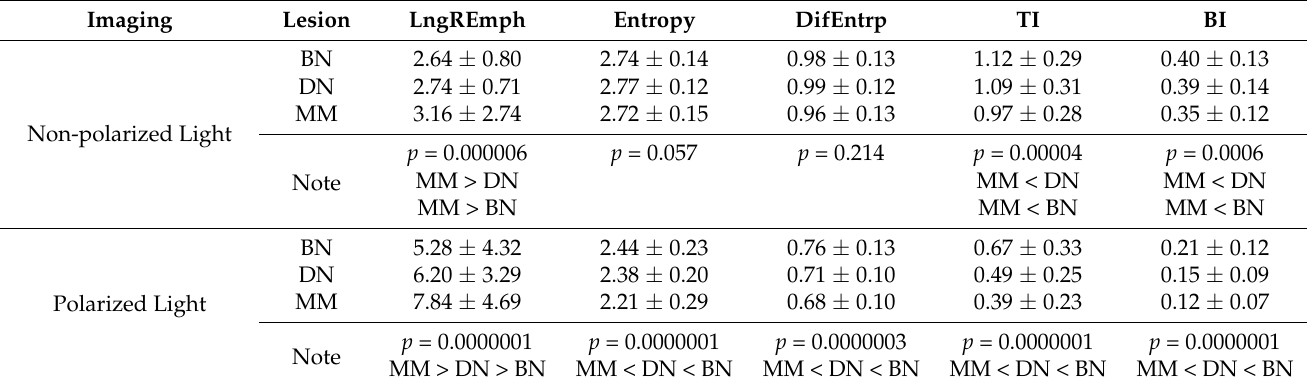
Table 1. Results of the investigated five texture features of skin lesions in polarized and non-polarized